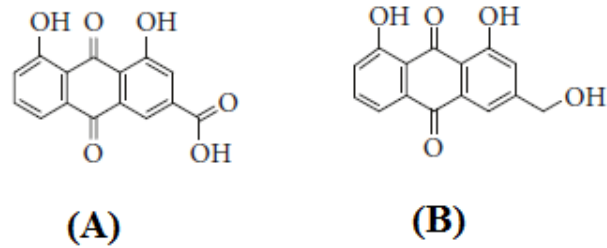
Figure 1. Molecular structures of ( A ) rhein and ( B ) aloe-emodin.